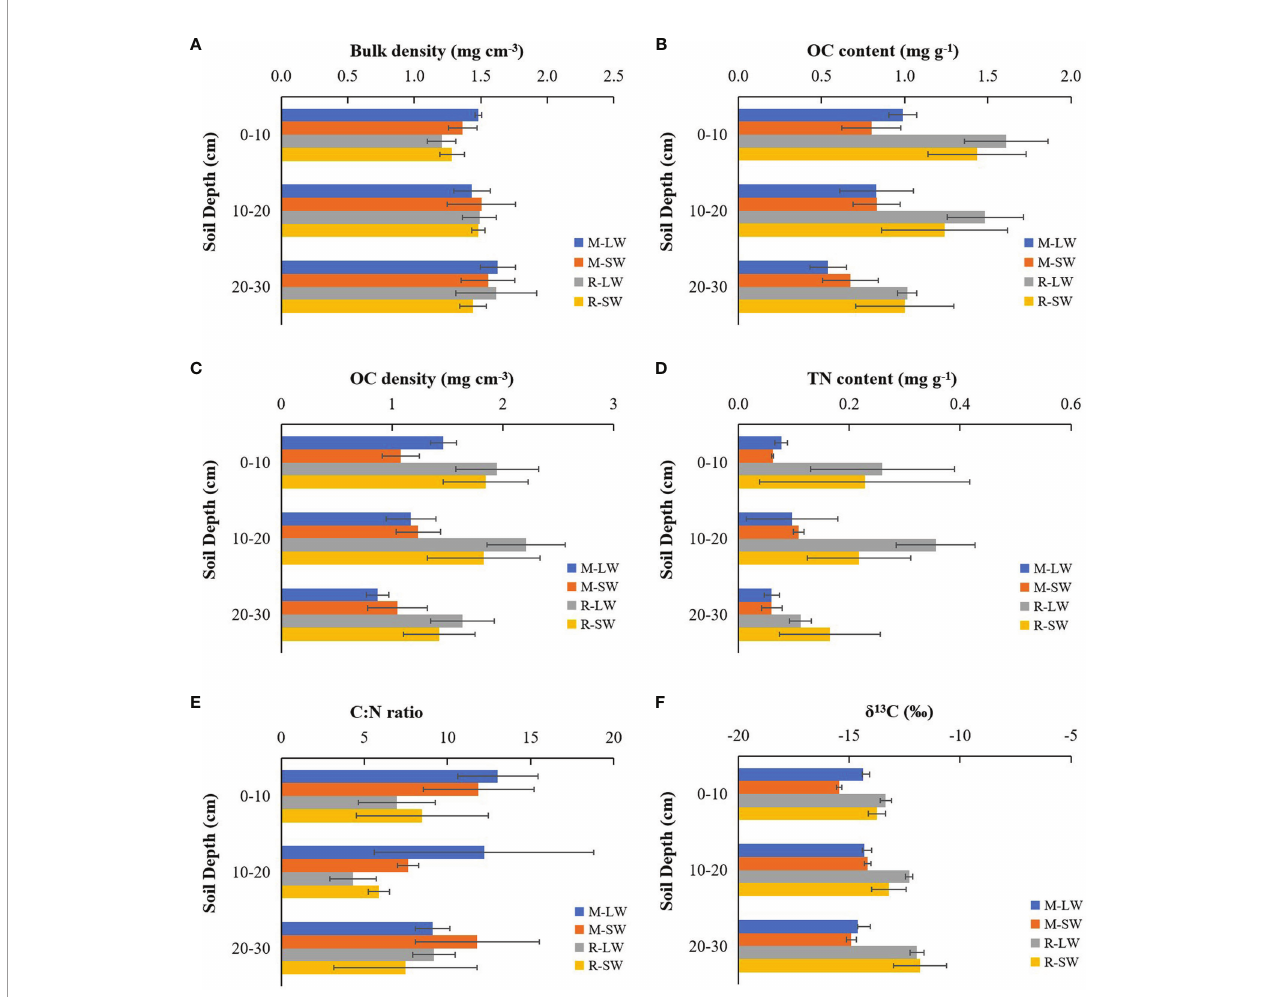
FIGURE 2 | Soil parameters of the two sampling stations at the two seagrass sites (M and R) in the Xincun Bay lagoon: (A) bulk density, (B) OC content, (C) OC density, (D) TN content, (E) C:N ratio and (F) d 13C. LW, landward station; SW, seaward